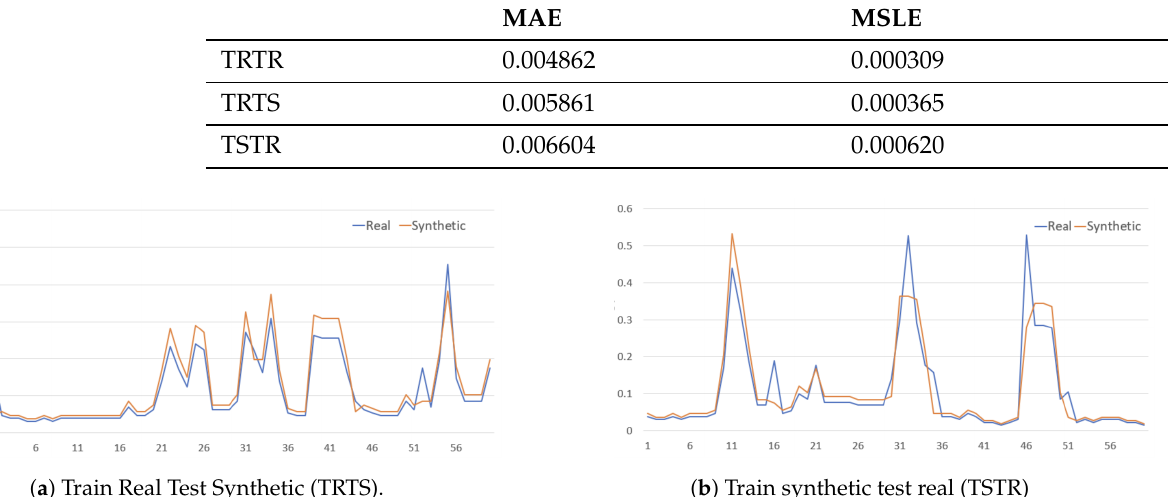
Figure 16. TRTS and TSTR graphs for UniMIB